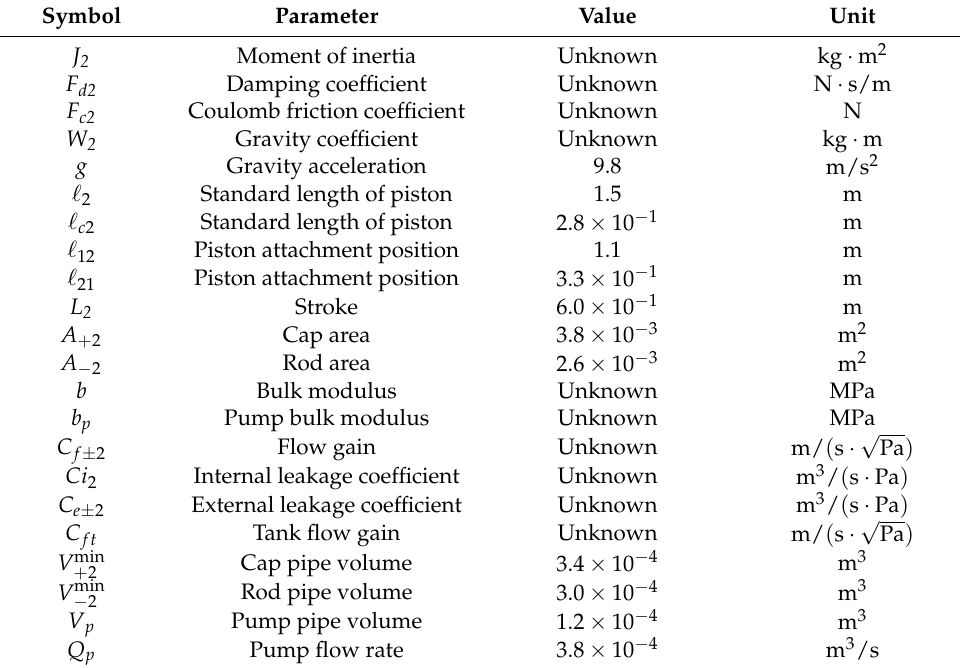
Table 1. Measured parameters and unknown